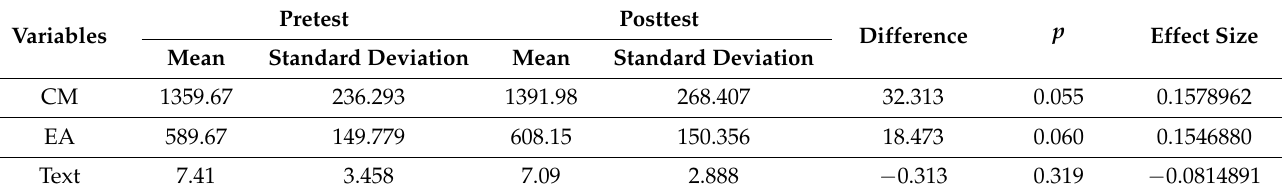
Table 11. Descriptive measurements and the contrast for related samples in the control group.